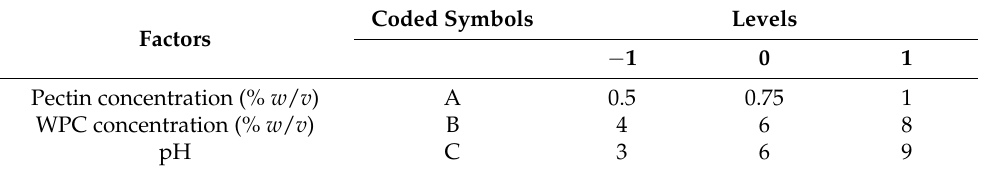
Table 2. Independent variables and their levels used in the central composite rotatable design.